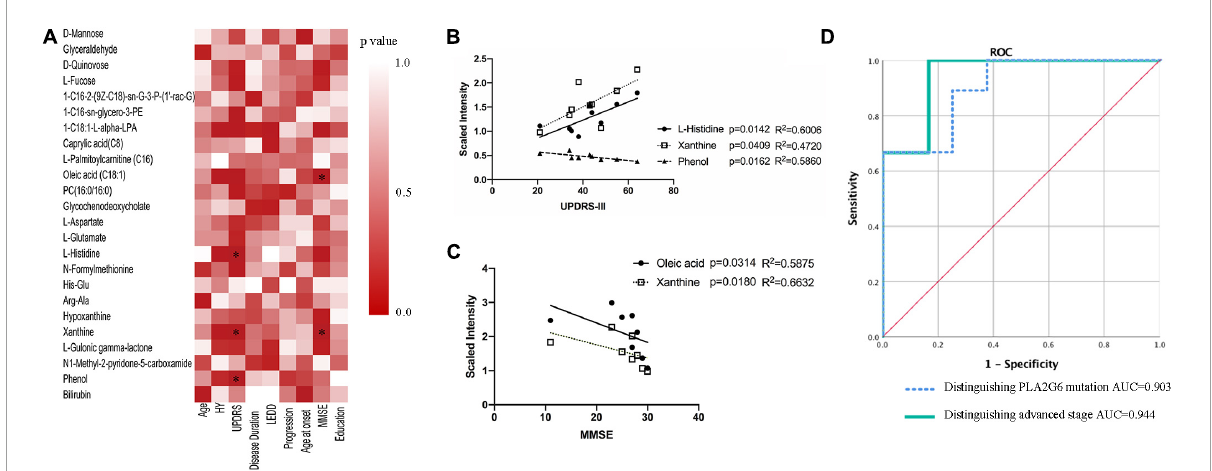
FIGURE2 Association of serum metabolites with clinical features. (A) Spearman’s correlation analysis between metabolites and clinical features. (B,C) Lineal regression of the four compounds with UPDRS-III scores and MMSE scores, respectively. (D) ROC curves of a logistic regression model for distinguishing PLA2G6 mutant vs. matched control, advanced stage vs. early stage. ∗ P < 0.05; HY: Hoehn and Yahr stage; LEDD: levodopa equivalent doses; UPDRS, Unified Parkinson’s disease rating scale; MMSE, Mini-Mental State Examination; AUC, area under the curve; ROC, receiver operator